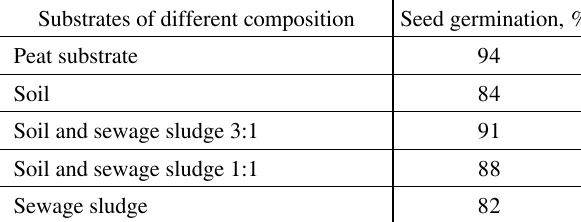
3 lentel ė . Data of germination of garden cress Substrates of different